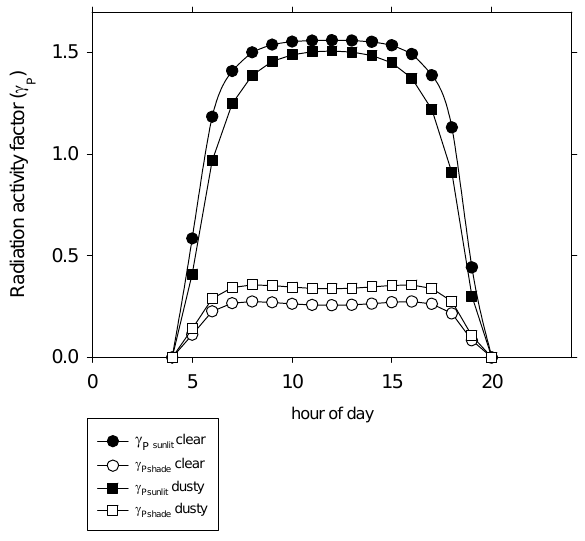
Fig. 2. Variation of γ p for the sunlit and shaded fractions of the canopy in clear and dusty atmosphere with respect to hour of the day, with LAI=6.